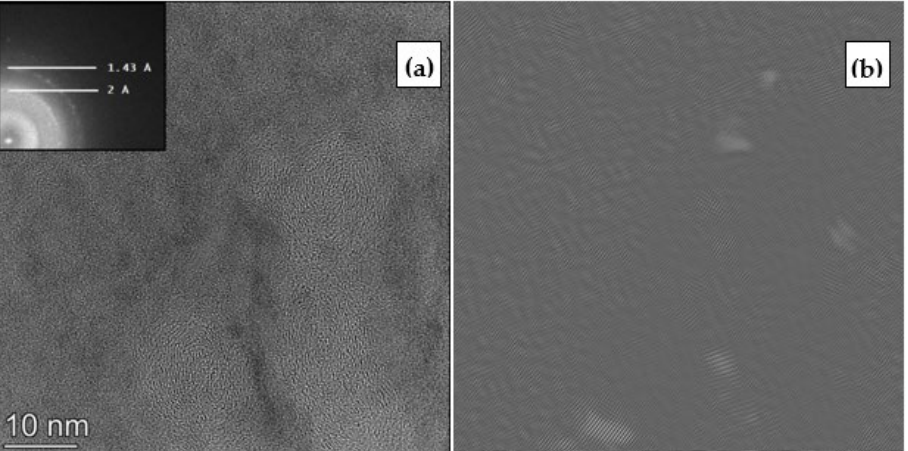
Figure 7. ( a ) HR-TEM micrograph depicting carbon nanotubes embedded in the amorphous matrix of the MgNiCuY_CNT_5 disk. The inset shows the corresponding fast Fourier transform indicating rings of Mg 2 Ni Fourier maxima. ( b ) Inverse fast Fourier transform constructed using the 1.43 Å and 2 Å rings of the FFT image.